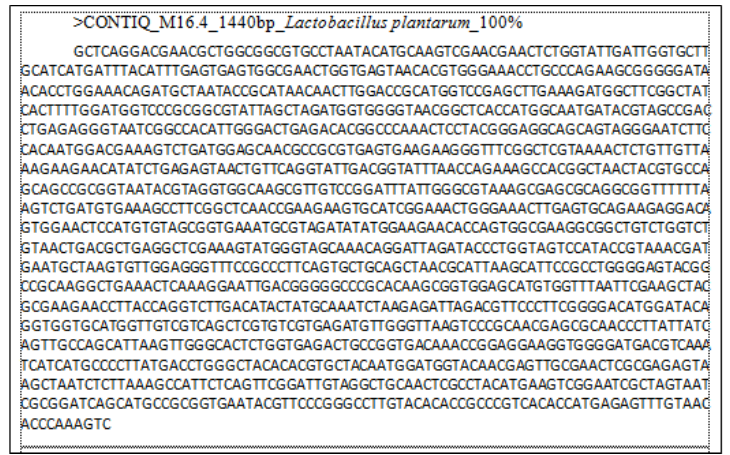
Figure 2. Result of lactid acid bacteria isolation from coconut oil and from palm oil with no evidence of growth.